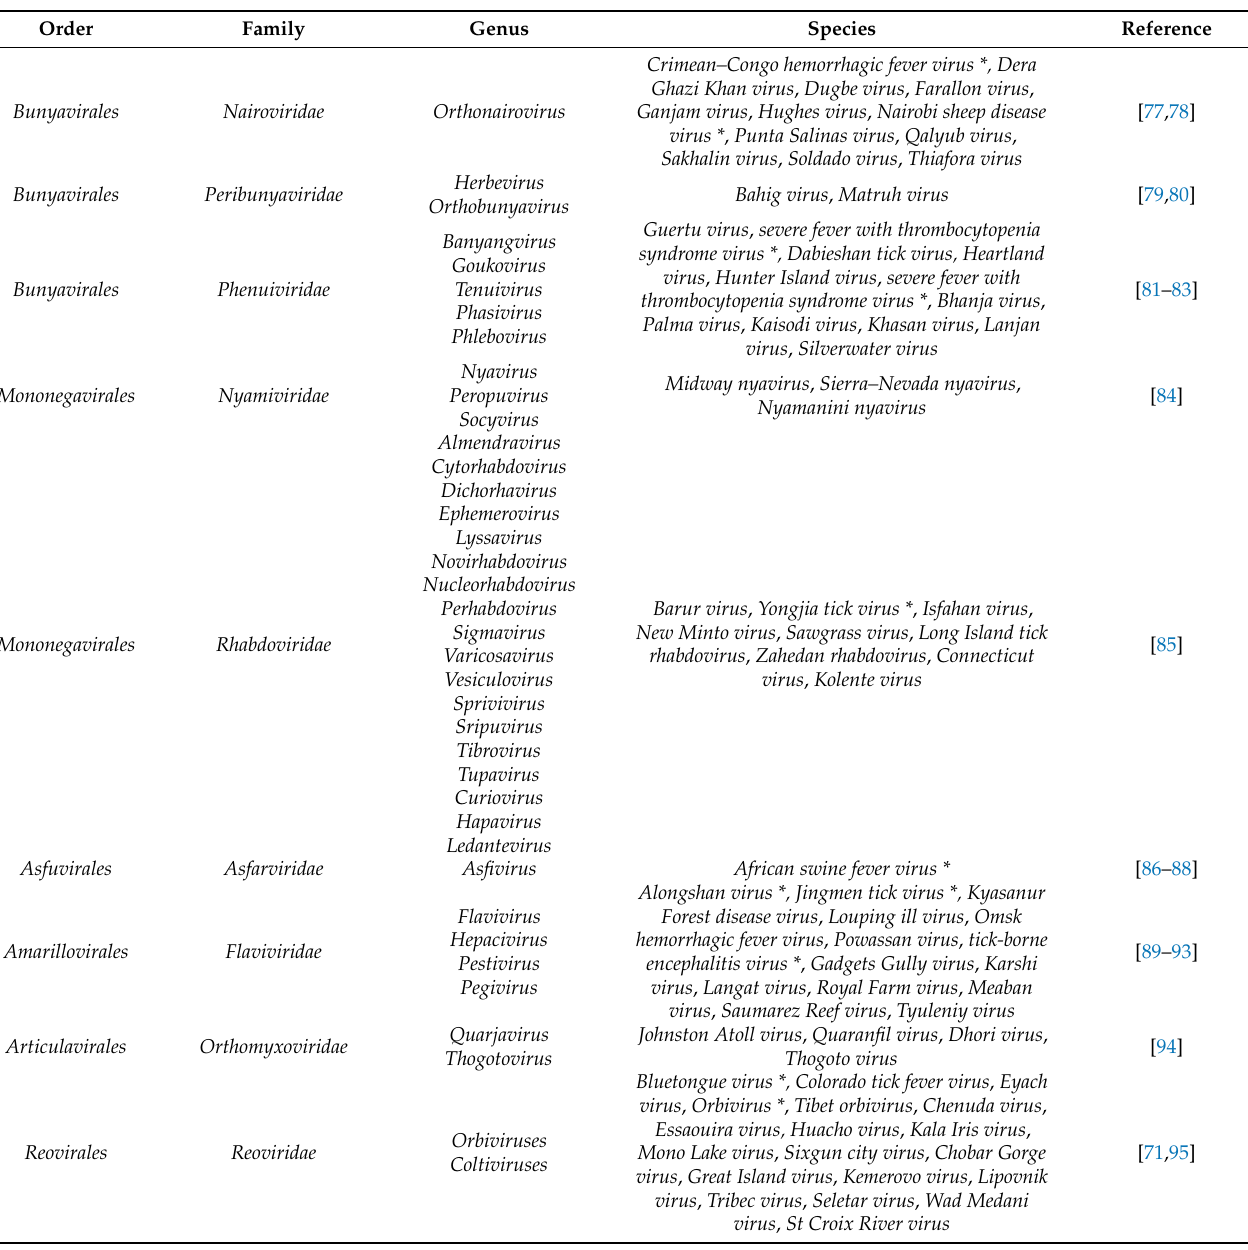
Table 2. Classification of tick-borne